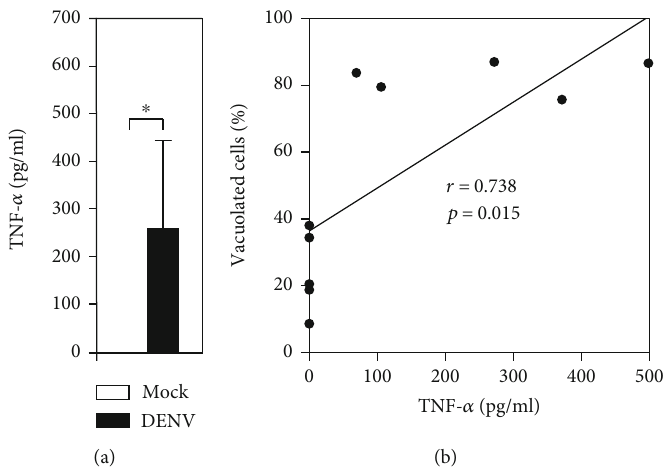
Figure 5: Abnormal production of TNF- α caused by DENV infection correlates with the cytopathological e ff ects 24h postincubation. (a) Following DENV ( MOI = 1 ) coculture in 100 μ l of WB ex vivo for 24 h, TNF- α production was measured in the plasma by ELISA. The quantitative data are depicted as the mean ± SD obtained from fi ve cases. ∗ p < 0 : 05 , compared to the mock group. (b) Furthermore, correlation analysis showed the strength of the relationship between TNF- α production and the induction of vacuolization, which is expressed numerically based on the r and p